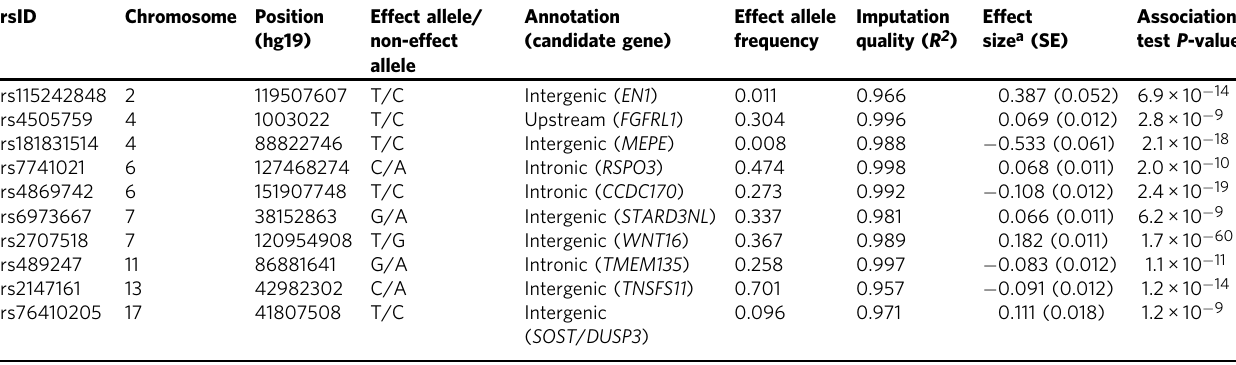
Table 1 Genome-wide signi fi cant loci in the discovery HUNT sample.